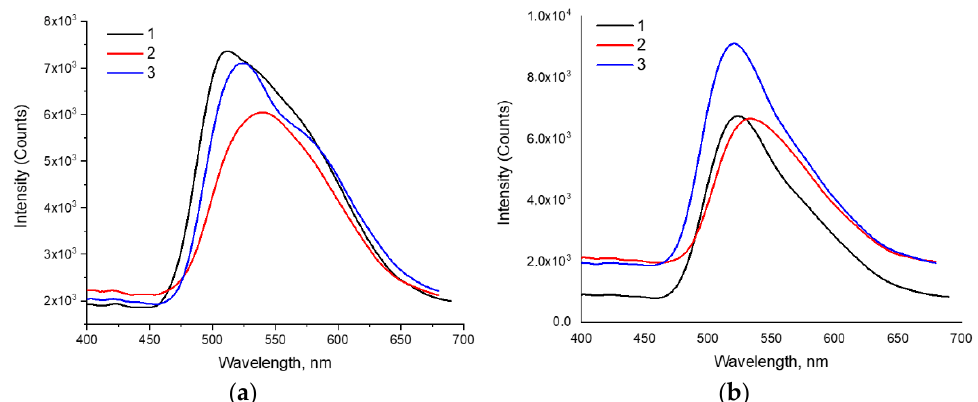
Figure 6. ( a ) Emission spectra of 6c in solid states ( λ ex = 350 nm): as prepared (1), after grinding (2), and after treatment with CH 2 Cl 2 (3). ( b ) Emission spectra of 6f in solid states ( λ ex = 350 nm): as prepared (1), after grinding (2), and after treatment with CH 2 Cl 2 (3).